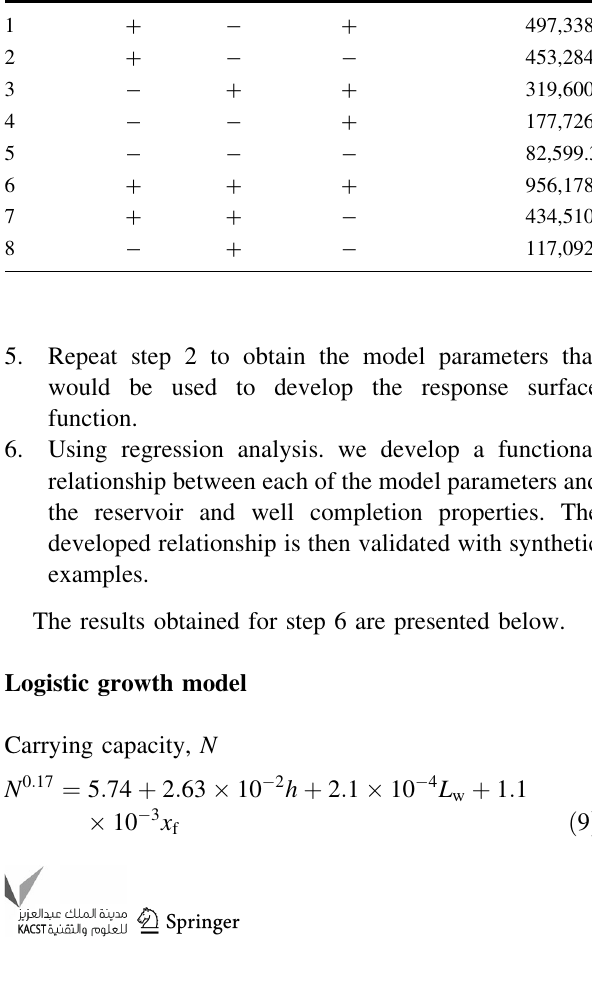
Table 9 Design table for variables with the main effect on the car- rying capacity, N Run number Thickness Well length Fracture half-length N (STB)